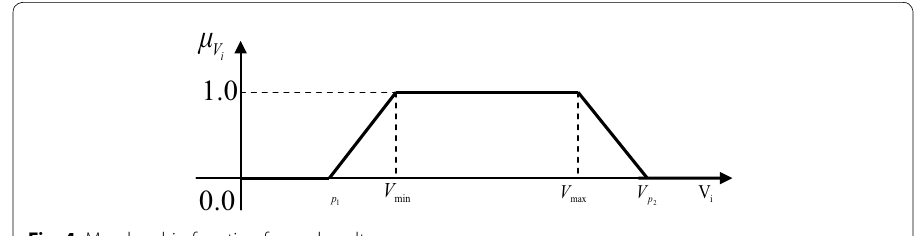
Fig. 4 Membership function for node